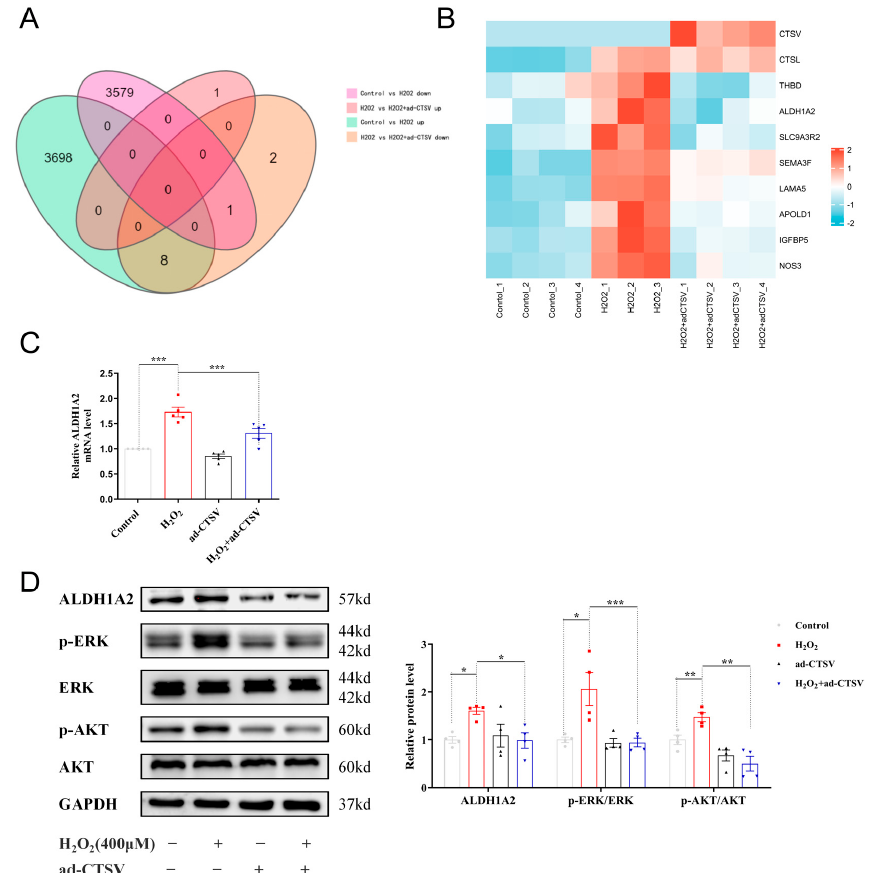
Figure 4. CTSV regulates ECs senescence via ALDH1A2. ( A ) HUVECs were treated with ad-negative control (NC) or ad-CTSV (MOI = 10) for 8 h and simulated with 400 µ M H 2 O 2 for 24 h after incubated in complete growth medium for 40 h. RNA sequencing analysis was conducted and Venn diagram of differentially expressed genes was presented. ( B ) Heatmap of the 8 genes that upregulated after H 2 O 2 treatment and downregulated after additional ad-CTSV treatment. ( C ) Relative mRNA level of ALDH1A2 in HUVECs treated with H 2 O 2 and ad-CTSV ( n = 5). ( D ) Western blot of ALDH1A2, p-ERK1/2, ERK1/2, p-AKT, and AKT in HUVECs ( n = 4). Data are presented as mean ± SEM. One-way ANOVA test was used. * p < 0.05, ** p < 0.01, *** p < 0.001.